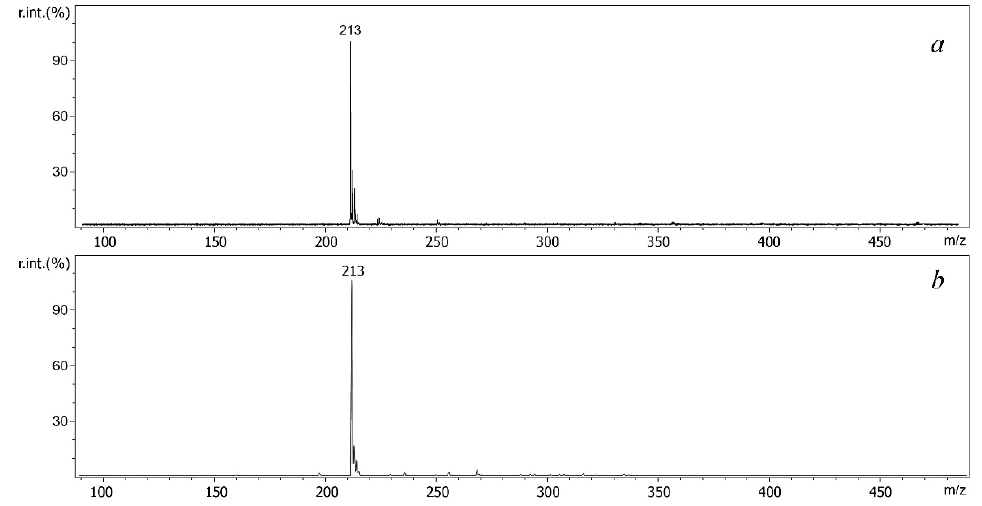
Figure 1. ESI ( a ) and MALDI ( b ) mass spectra recorded for S-ethyl dibenzothiophenium triflate ( m / z 213 ion corresponds to the cationic part of the derivative).